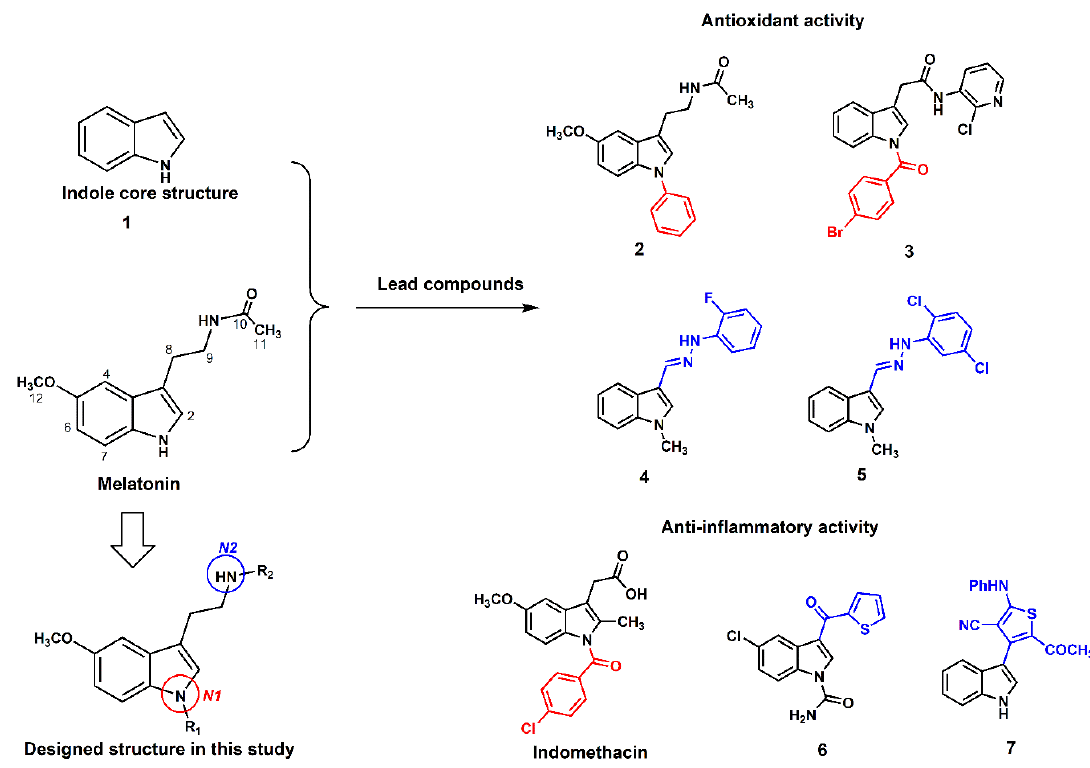
Figure 1 . Antioxidant and anti-inflammatory lead compounds relevant to this study [22–28] . Figure 1. Antioxidant and anti-inflammatory lead compounds relevant to this study